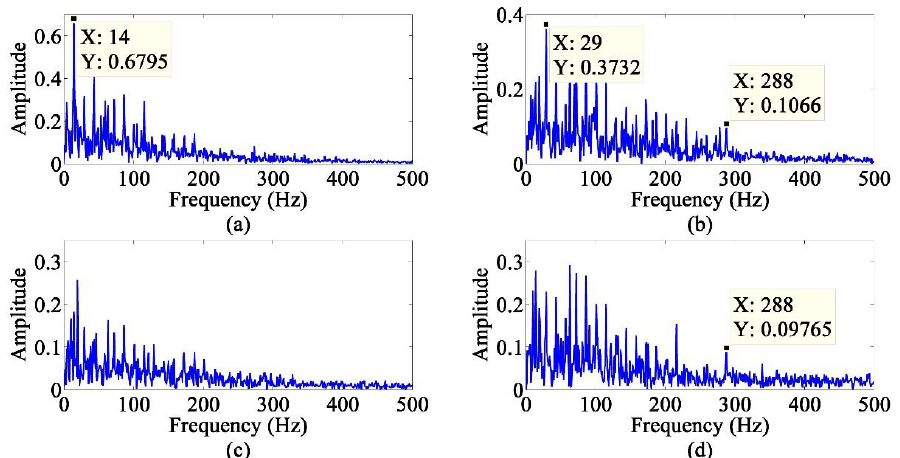
Figure 6. The Hilbert envelope spectra of each component signal after variational mode decomposition (VMD). ( a ) Component signal 1. ( b ) Component signal 2. ( c ) Component signal 3. ( d ) Component signal 4.